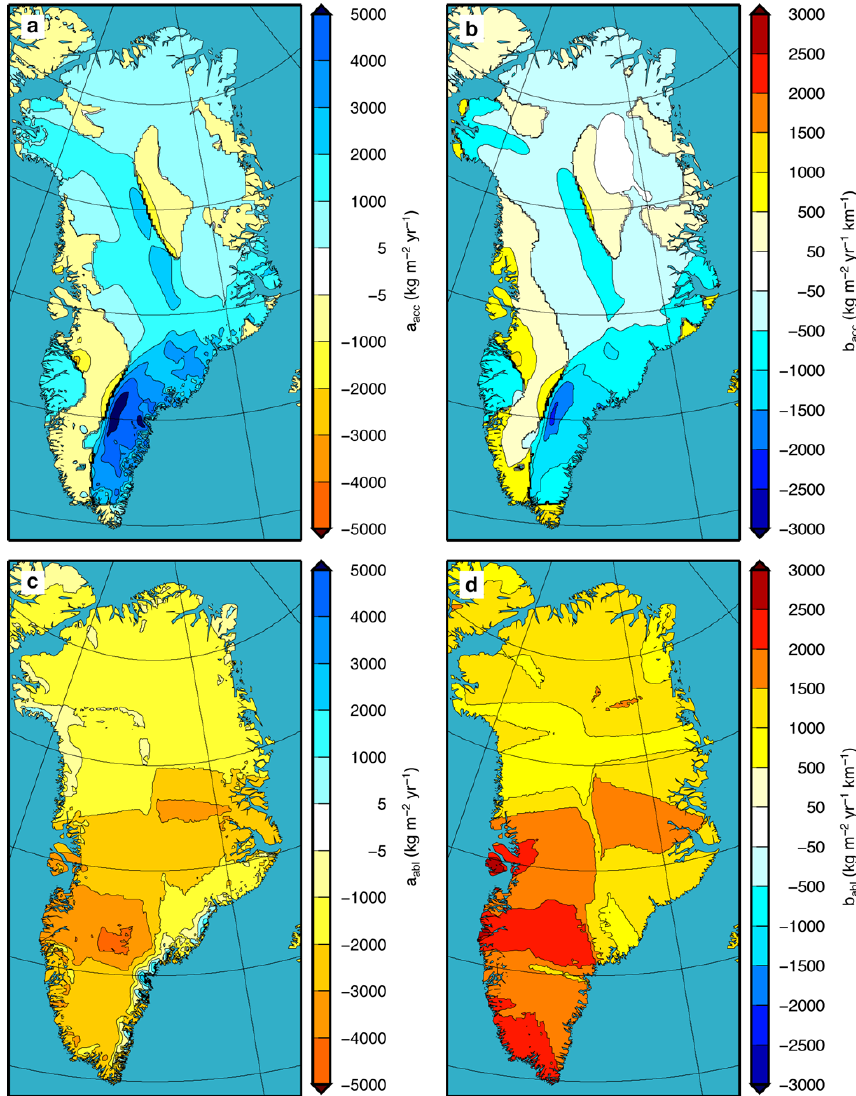
Fig. 4. Coefficients a and b in the spatially varying equation SMB= a + b H s for (a) and (b) the accumulation regime, and (c) and (d) for the ablation